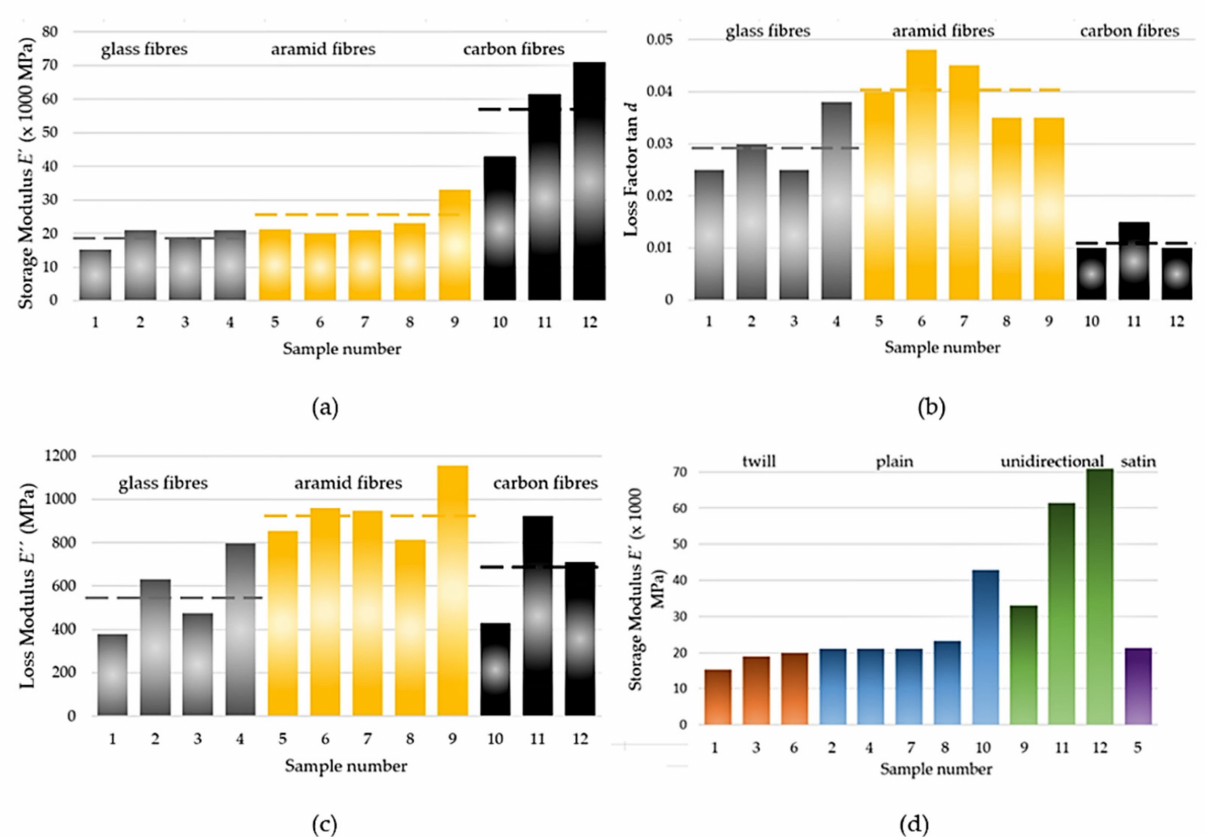
Figure 8. Effects of fibre material on: ( a ) storage modulus ( E (cid:48) ), ( b ) loss factor (tan d ), ( c ) loss modulus ( E (cid:48)(cid:48) ), and ( d ) the effect of weaving on E (cid:48) ; dashed lines represent the average values. Another parameter for comparison is the loss factor (tan d ), which indicates the damping of the material (i.e., degree of energy dissipation) (Figure 8b). The lowest loss factor was for the CFRP, and the GFRP and AFRP samples had 2.52-times and 3.48-times larger loss factors in the range of − 50 to 60 ◦ C,